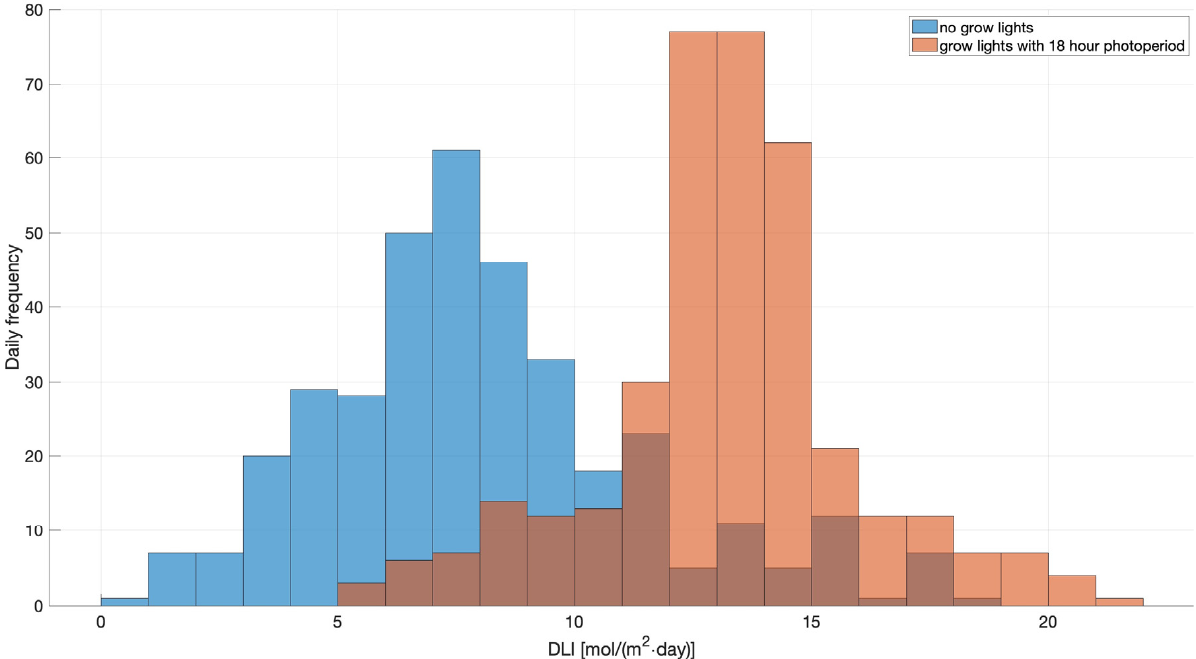
Figure 14. Annual histogram of the calculated DLI for each day of the year with and without grow lights.